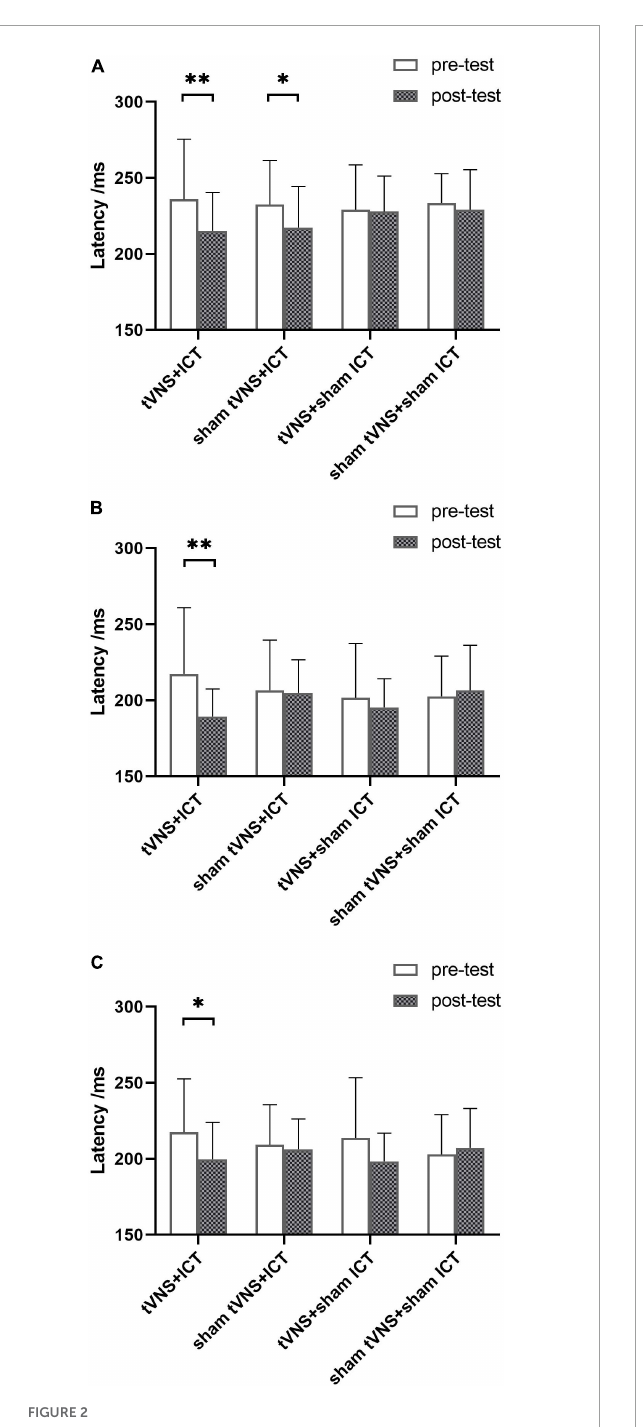
FIGURE2 Summary of signal-N2 latency in SST. (A) Signal-N2 latency between pre- and post-test for each group in frontal region. (B) Signal-N2 latency between pre- and post-test for each group in fronto-central region. (C) Signal-N2 latency between pre- and post-test for each group in central region. Error bars represent the standard deviation of the mean. ∗ p < 0.05, ∗∗ p < 0.01. larger alpha power value in the tVNS + ICT group than in the sham tVNS + ICT ( p < 0.001) and tVNS + sham ICT ( p < 0.001) groups, and marginally significantly larger alpha power in the tVNS + ICT group than in the sham tVNS + sham ICT group ( p = 0.077) in the fronto-central region.